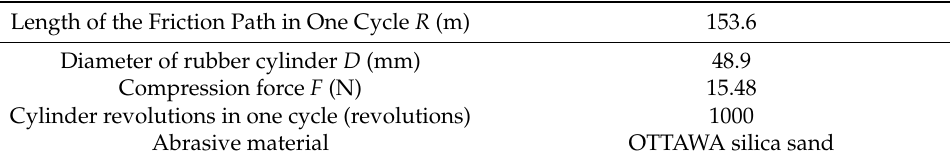
Table 4. Parameters of the test equipment.